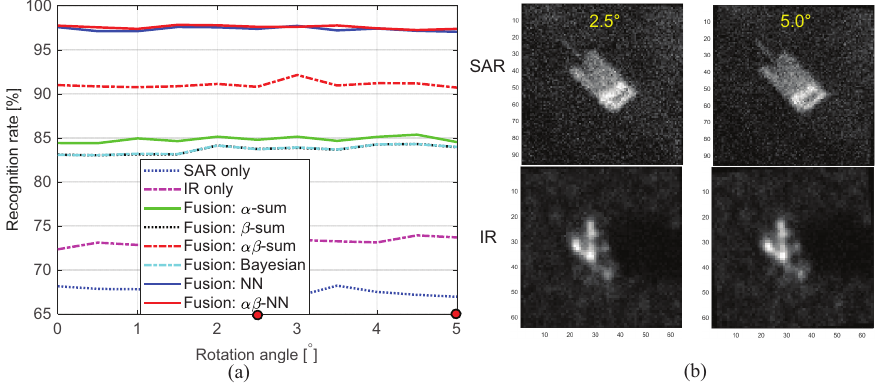
Figure 20. Performance evaluation results for the rotational variation: ( a ) recognition rate vs. rotation angle [ ◦ ]; ( b ) test examples of SAR and IR images at different rotation